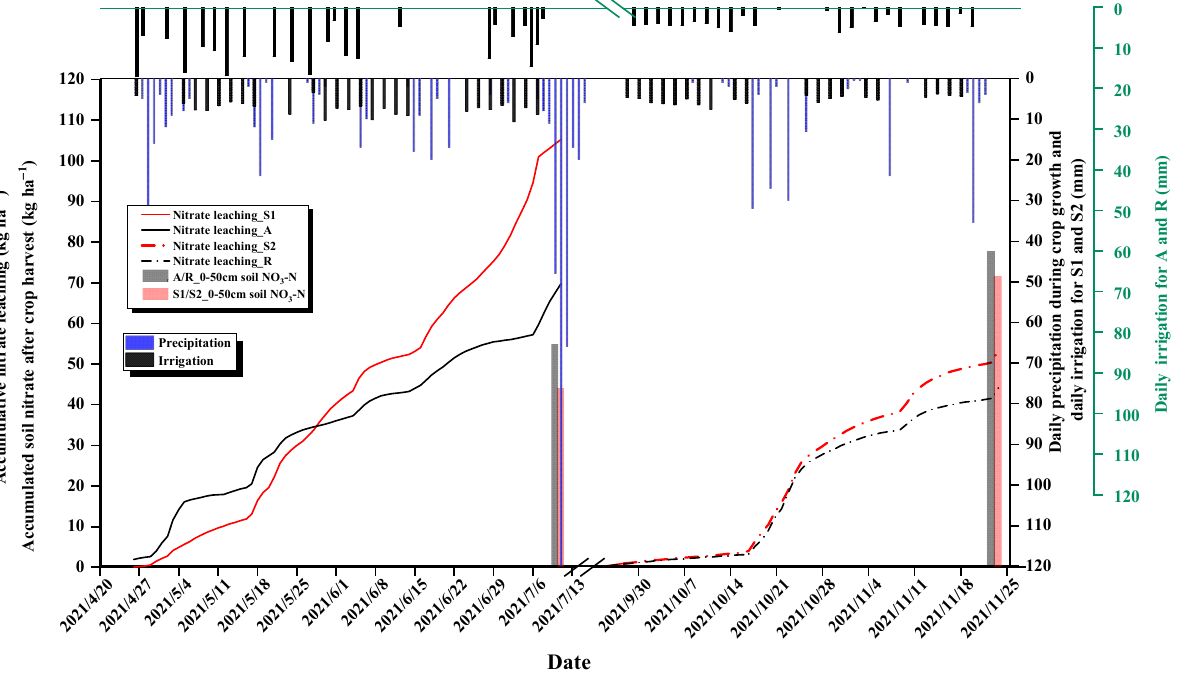
Figure 13. Accumulative nitrate leaching (2 m soil depth) during the growing period and accumulated soil nitrate content after crop harvest at 0–50 cm root zone depth (left axis); Daily precipitation amount in two seasons and daily irrigation amount for S1, S2, A and R (S1 and S2 using inner right axis, while A and R using outer right axis).